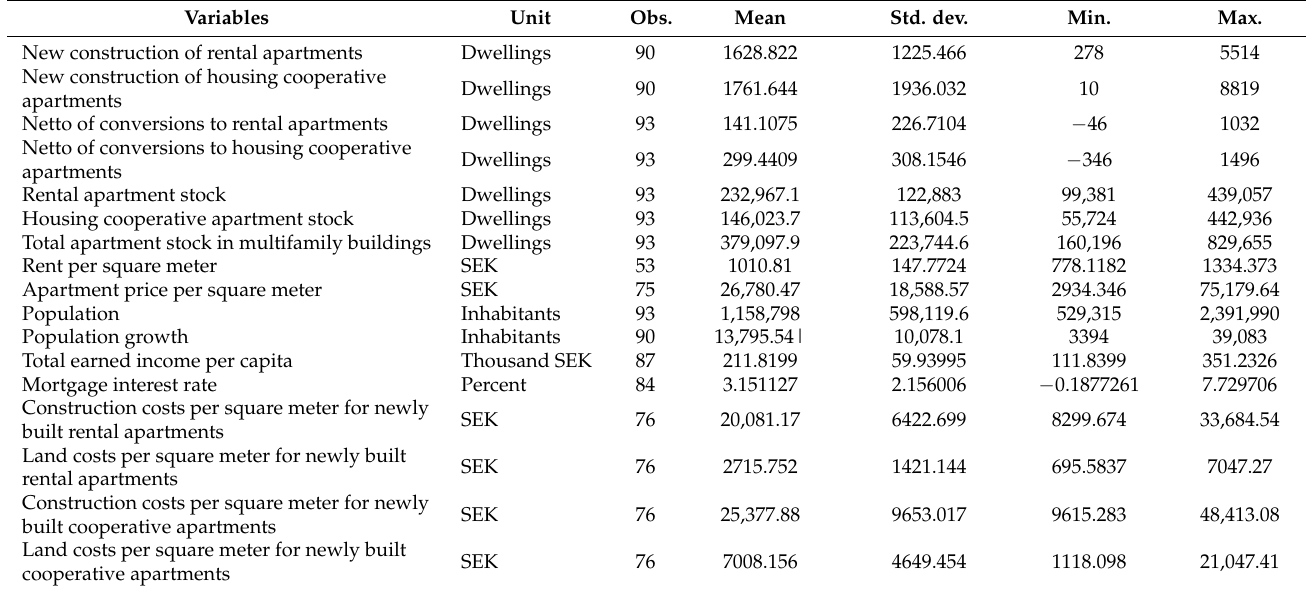
Table 3. Summary statistics of